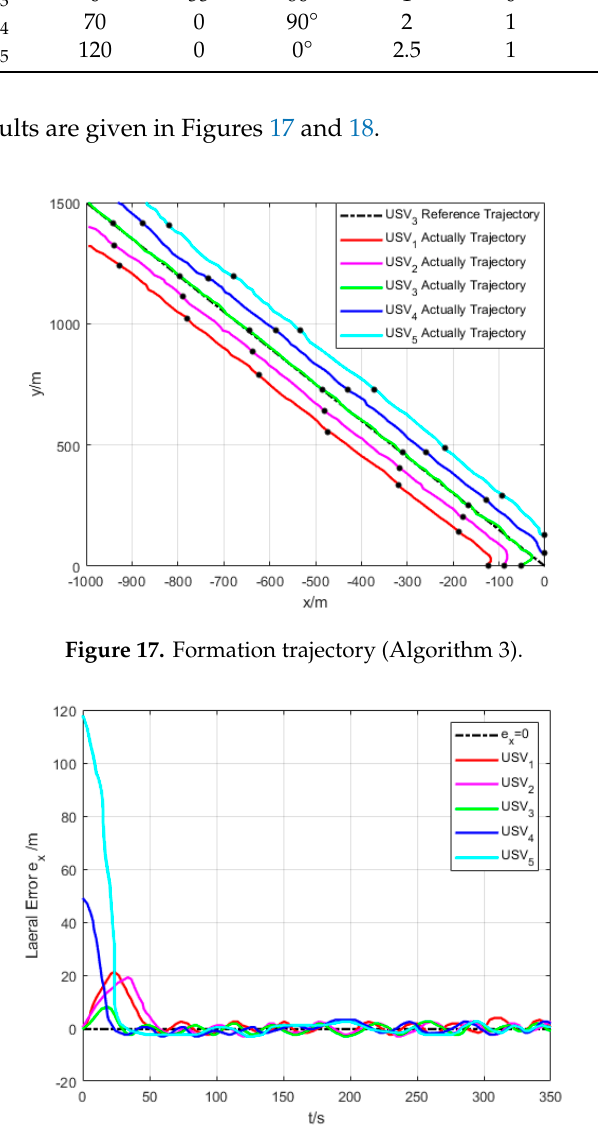
Figure 18. Lateral error (Algorithm 3).